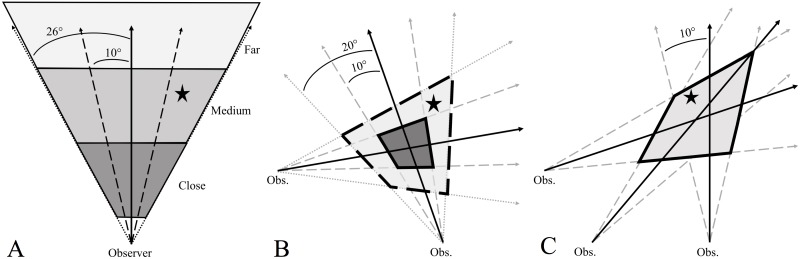
Examples of how incorporating observer error in howl surveys helps focus the search area, and presumably the time spent searching for, wolf homesites (black star).Observer error is the difference (in degrees) between an observer’s estimated bearing (solid black arrows) of a wolf response and the true bearing of the homesite. When one bearing is obtained (A), the observer estimates how close the response is (close, medium, far) and then incorporates ±10° and ±26° error (dashed black lines) around their bearing to determine an area that likely contains the homesite. When two bearings are obtained (B), incorporating ±10° and ±20° error around observer bearings creates two polygons: a smaller 10°-error polygon (dark gray, solid outline) that will commonly contain the homesite and a larger 20° -polygon (light gray, dashed outline) that almost certainly contains the homesite. When at least three bearings are obtained (C), incorporating ±10° error around observer bearings will create an error polygon that almost certainly contains the site.